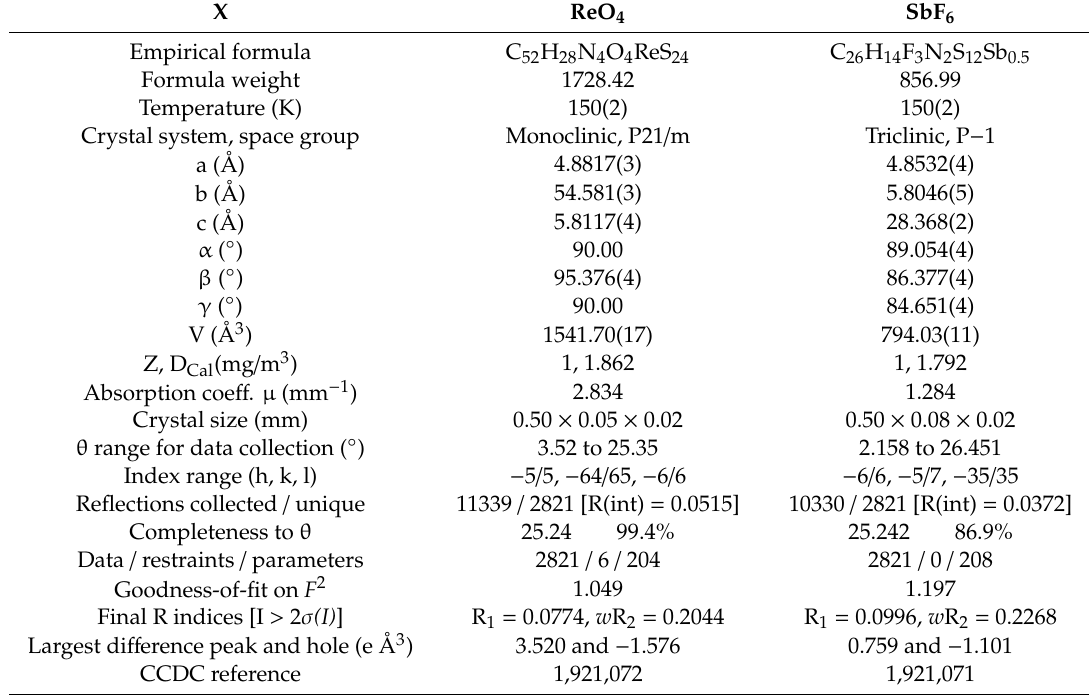
Table 1. Crystal data for β ”-(CNB-EDT-TTF) 4 X 4 compounds with di ff erent anions